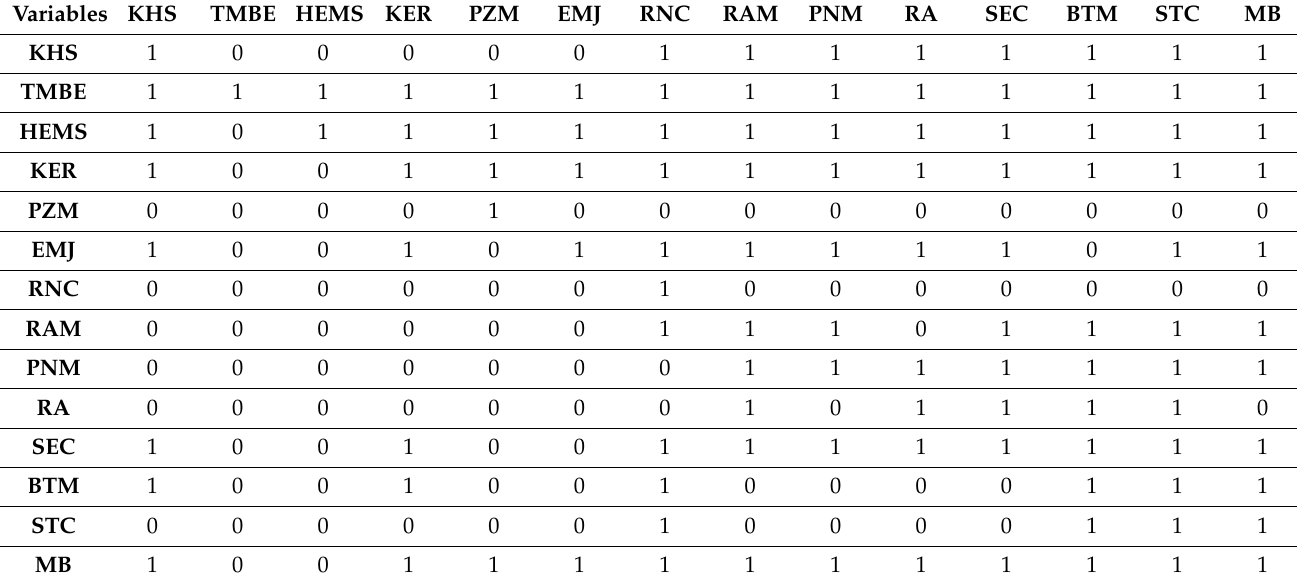
Table 8. Final received matrix (Ref: